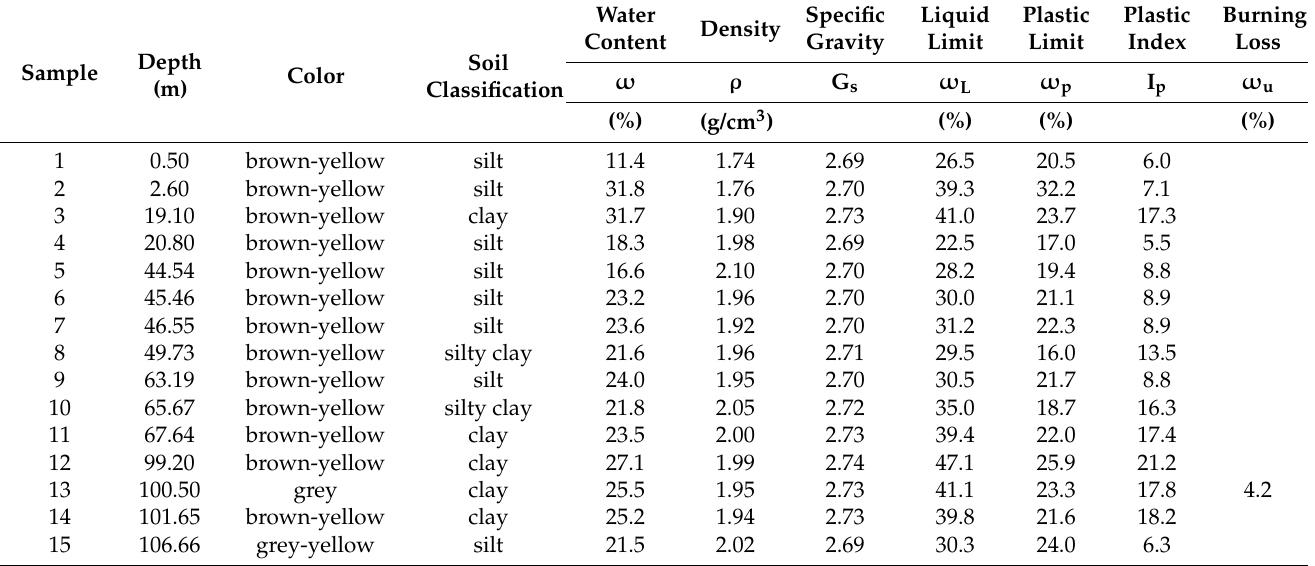
Table 2. Basic physical and mechanical parameters of